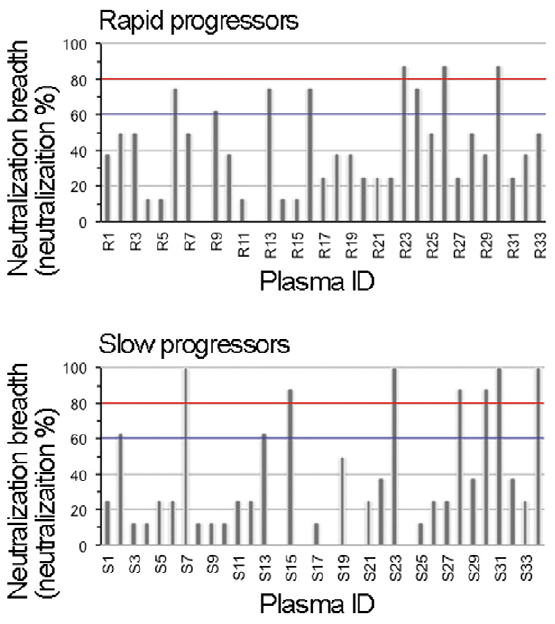
Figure 3. Comparison of the neutralization breadth between plasma derived from rapid and slow progressors. The proportion of AE-Env-recombinant viruses in which replication was inhibited by a plasma sample was calculated and plotted. The levels of plasma- mediated neutralization against 60% and 80% of recombinant viruses tested are highlighted by horizontal blue and red grid lines, respectively. Plasma IDs are denoted below the panels.